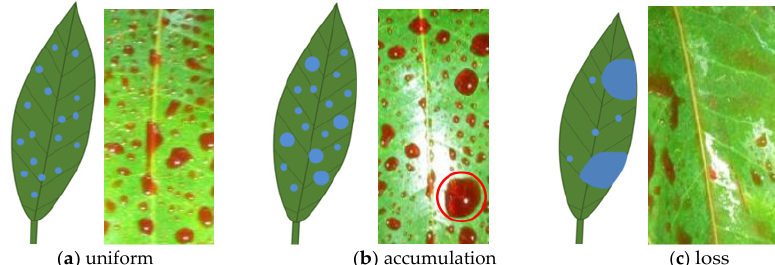
Figure 1. Schematic diagram of the deposition states of droplets on the target leaves; ( a ) uniform; ( b ) accumulation; ( c ) loss.